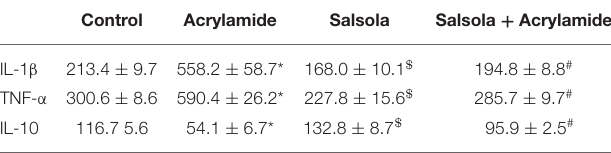
TABLE 5 | Protective effects of Salsola against acrylamide-induced alterations in cytokines